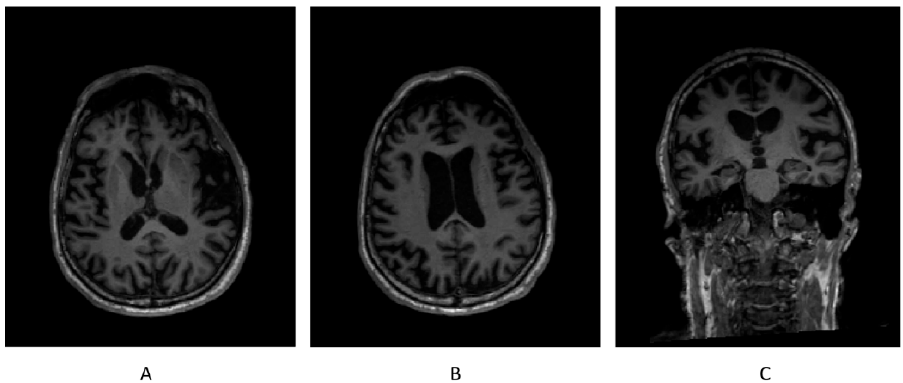
Figure 4. High-resolution 3D T1-weighted sequence of the structural brain MRI on 1 October 2021. ( A ) Axial slice displaying normal bilateral basal ganglia, ( B ) axial slice displaying atrophic bilateral frontal lobes, and ( C ) coronal slice displaying normal bilateral hippocampus.